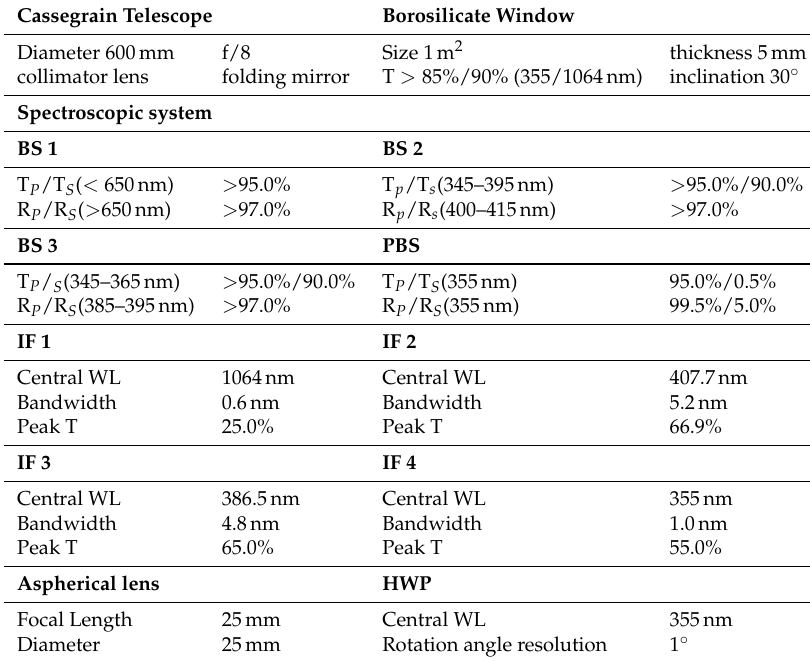
Figure 4. Layout of the optical components inside the spectroscopic filter with the indicated light path. The Beam Splitter (BS1), Interference Filter (IF1), aspherical lens, and Avalanche Photodiode (APD) were used for the infra-red Mie channel. BS2, IF2, and a Photomultiplier Tube (PMT) were used for the H 2 O channel. BS3, IF3, and a PMT were used for the N 2 channel. The Half Wave Plate (HWP), Polarization Beam Splitter (PBS), two interference filters (IF4), and two PMTs were used for S and P polarization UV Mie–Rayleigh channels. Table 2. Specifications of the components used in the spectroscopic system. The beam splitter (BS1), interference filter (IF1), and aspherical lens were used for the infra-red Mie channel. BS2 and IF2 were used for the H 2 O channel. BS3 and IF3 were used for the N 2 channel. HWP, PBS, and two interference filters (IF4) were used for S and P polarization UV Mie–Rayleigh channels. T P / S : P/S polarization transmittance, R P / S : P/S polarization reflectance, WL: